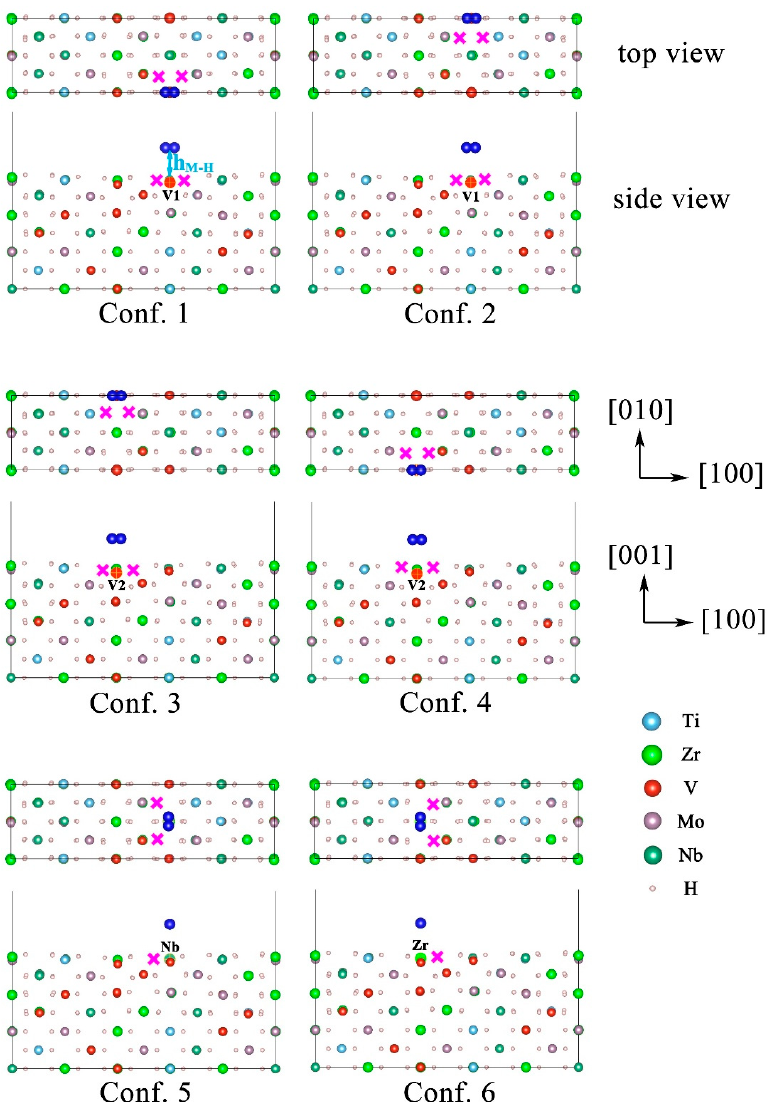
Figure 2. Schematic view of the six considered configurations for the parallel molecular hydrogen desorption on the HEA TiZrVMoNb hydride (110) surface. The desorbed H atoms are represented by dark blue spheres. The nearest-neighboring metal atoms are represented by the spheres with a cross and are labeled by V1, V2, Nb and Zr. The pink cross corresponds to the original positions of the desorbed hydrogen atoms. Here, h M-H refers to the vertical distance between the H 2 molecule and the nearest-neighboring metal atom on surface before structural optimization.